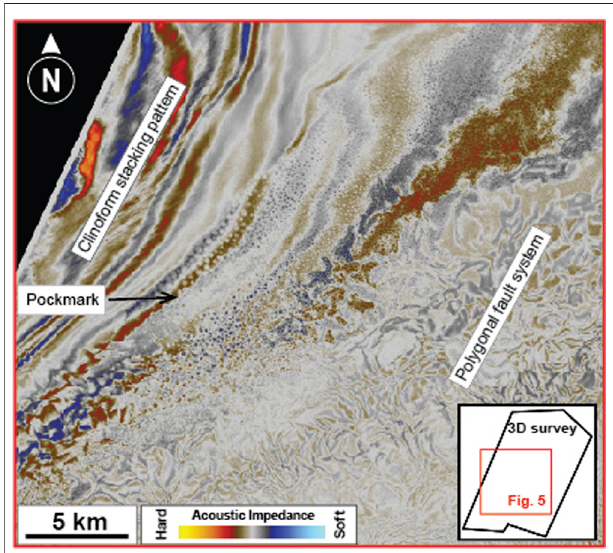
FIGURE 5 | Seismic time slice through 1,492 ms shows a wide area of paleo-pockmarks within the Middle Eocene mudstone